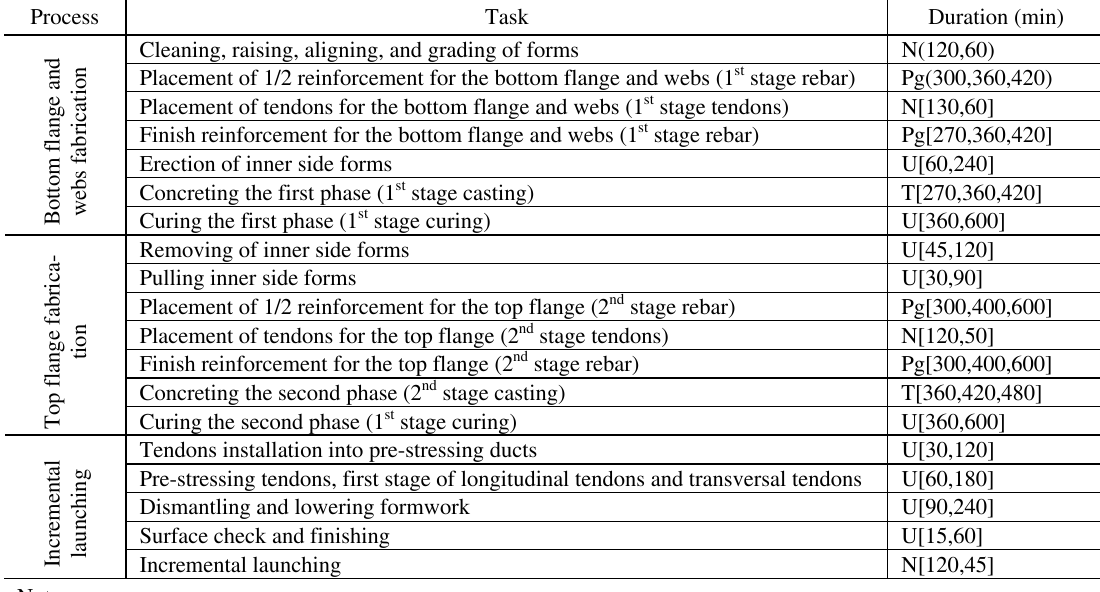
Table 4 . Durations of single form method tasks